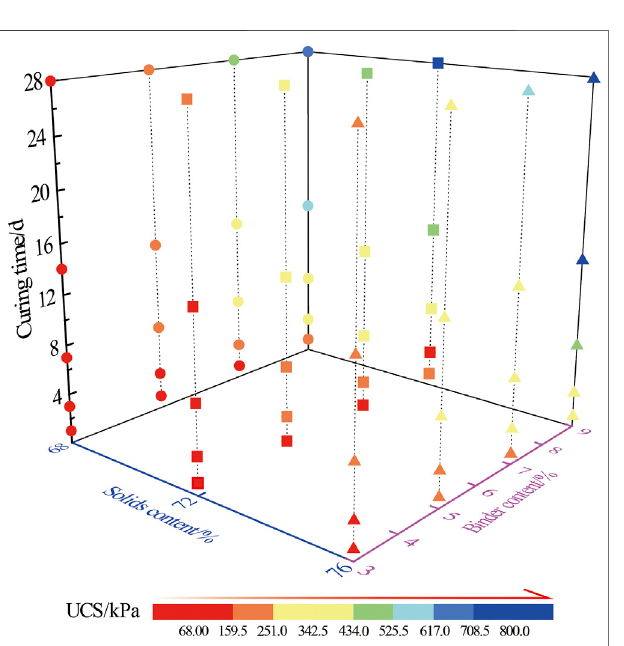
FIGURE 6 | The value of UCS corresponding to different conditions. sphere color shows an obvious difference when the spheres are along the X -axis or Z -axis, and the color difference of the spheres are more obvious along the direction of the Y -axis and the Z -axis.